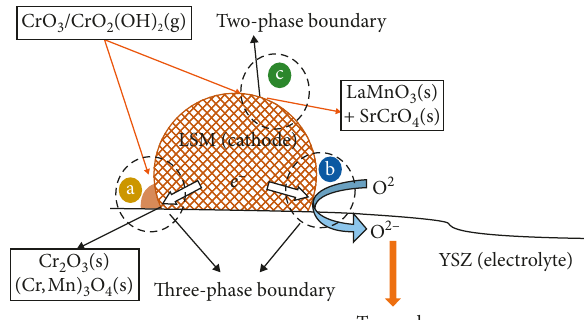
Figure 7: A schematic representation of the general types of Cr poisoning reactions that may take place: two-phase boundary reactions and three-phase boundary reactions.